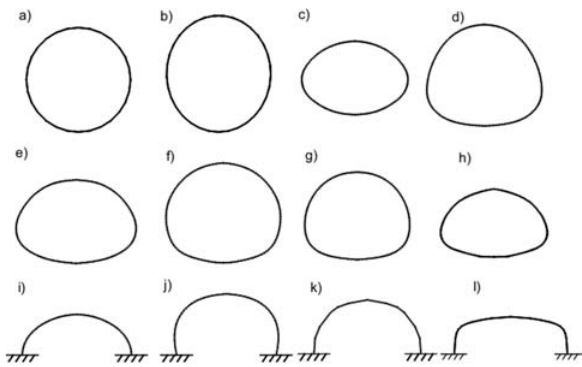
fig. 1. The shapes of steel flexible structures: a – circular; b – elliptical vertical; c – elliptical horizontal; d – pear; e, f, g, h – arched-circular; i, j, k – arched; l –